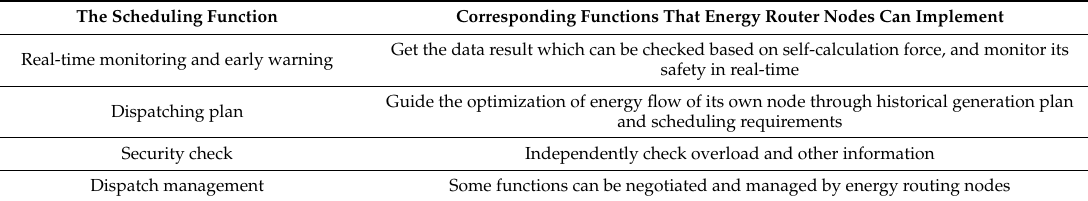
Table 1. The existing scheduling functions which the energy router / switch node can